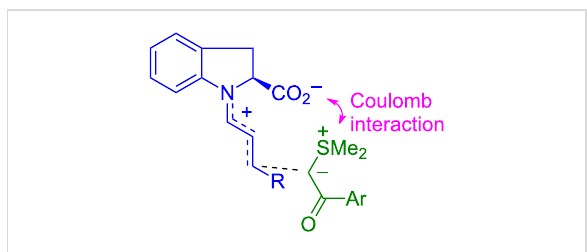
Figure 15: Electrostatic activation of iminium activated cyclopropana- tions with sulfur